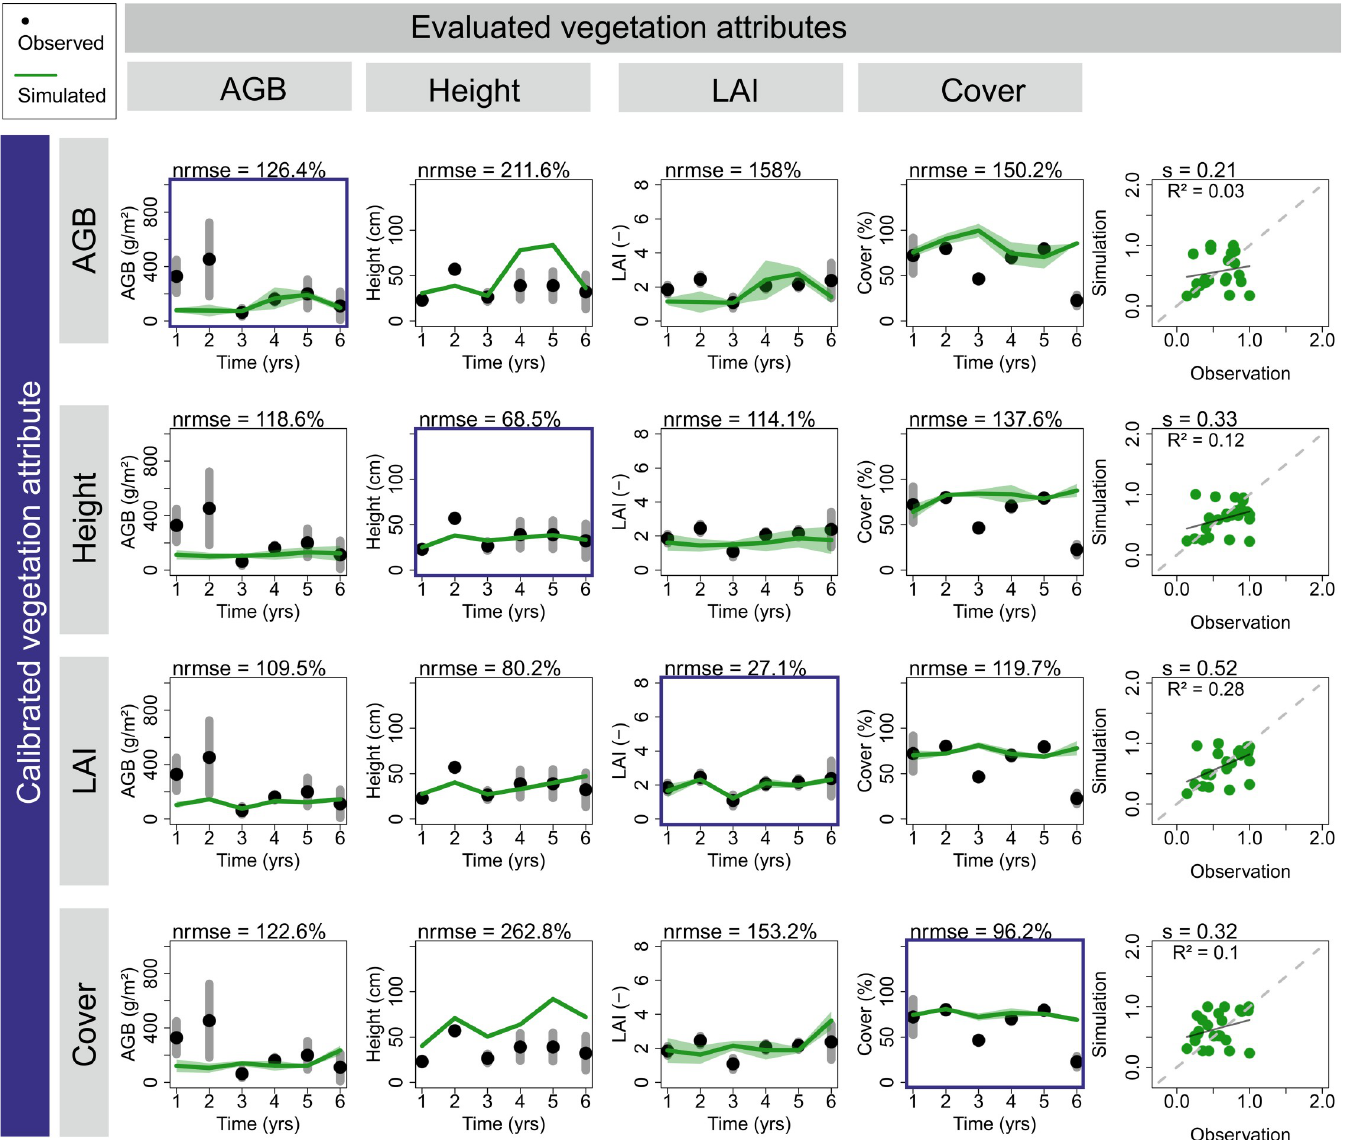
Fig 4. Comparison of different observed vegetation attributes included as single attribute in the inverse model parameterization. The calibrated vegetation pattern is framed by a blue rectangle while the other vegetation patterns are shown for evaluation purposes (example of F . pratensis monoculture, using MAPE as cost function). Green lines (and shaded polygons) describe simulations (yearly mean and range) while black dots and grey lines describe the observations (yearly mean and range). All four vegetation patterns are normalized and summarized in a 1:1 plot (right panel). See methods for